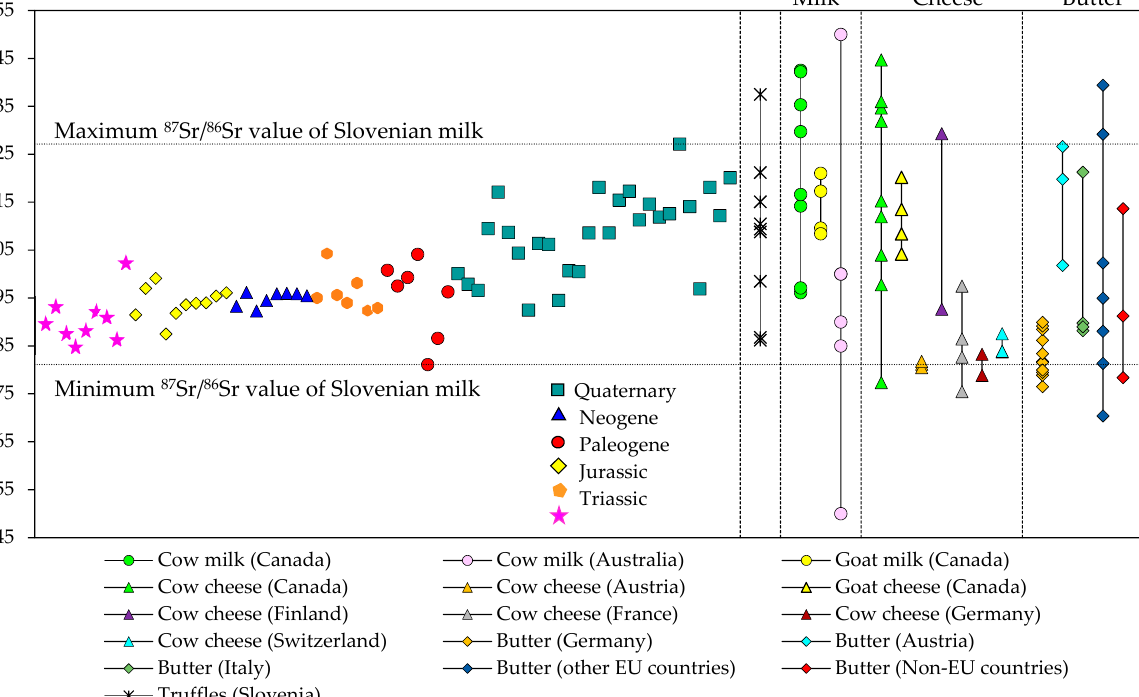
Figure 4. 87 Sr/ 86 Sr ratios versus Sr concentrations in milk from different geological regions.